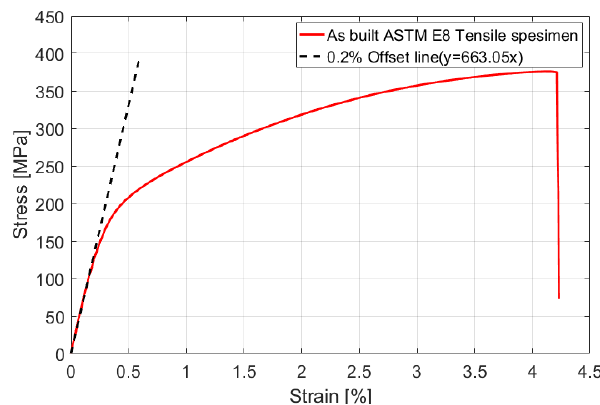
Figure 8. Stress-strain relationship through tensile testing of specimen #1. Table 2. Tensile test result of specimen manufactured by ASTM E8 standard. Specimen Num.